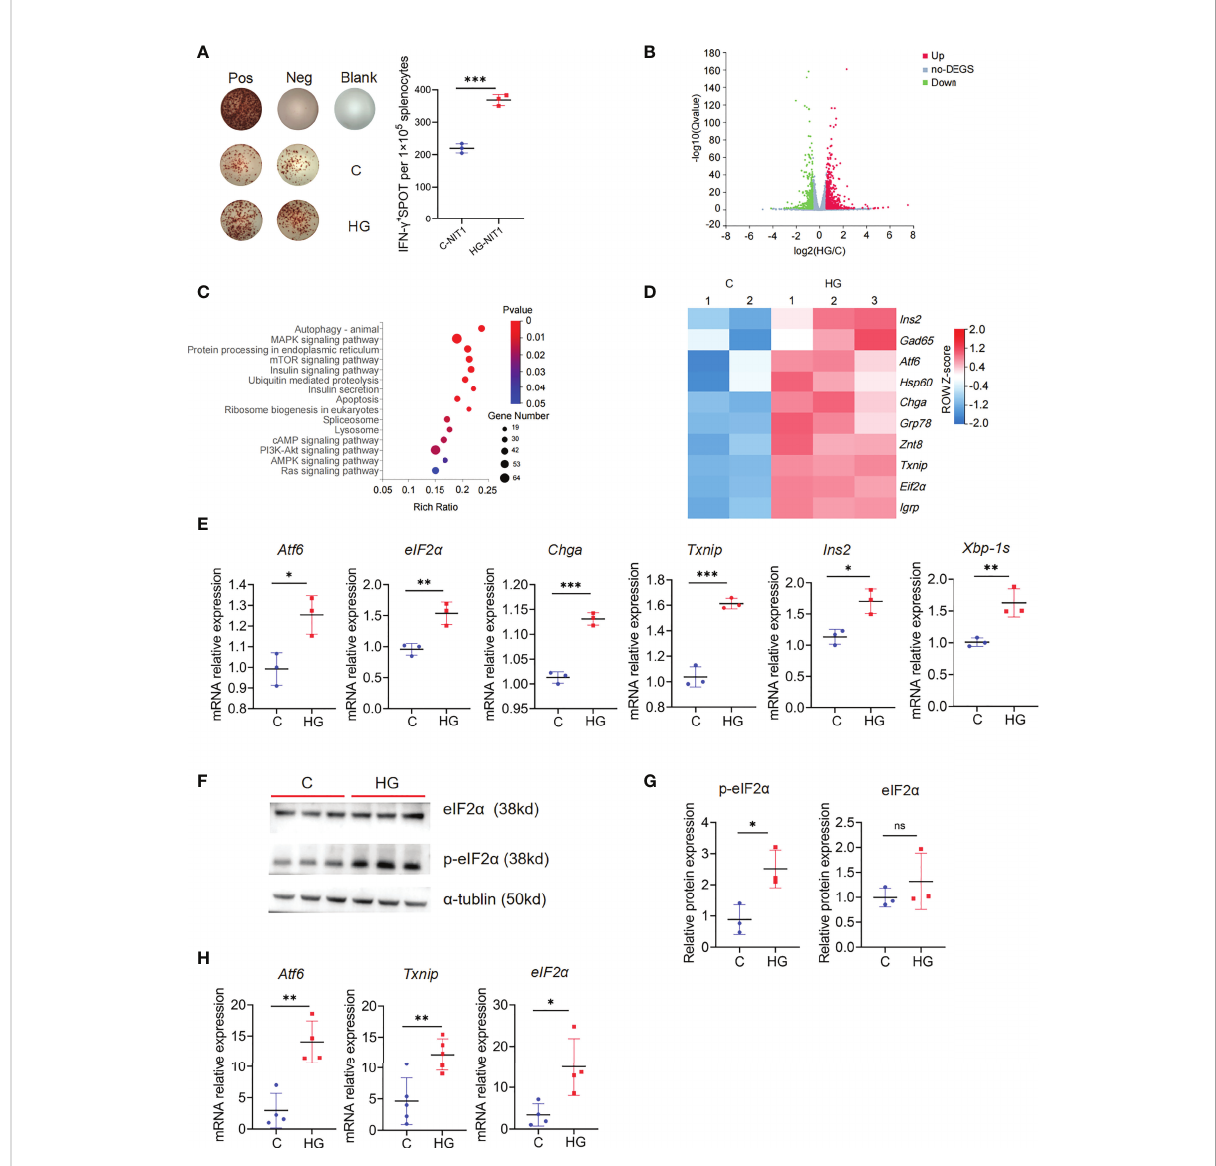
FIGURE 2 High-glucose treatment enhance the immunogenicity of NIT-1 cells and up-regulate the autoantigen and ERS related genes expression (A) Representative plots of IFN- g production by NOD mouse splenocyte alone (Neg), or incubated with untreated (C-NIT1) or high-glucose treated NIT-1 cells (HG-NIT1), or PMA plus ionomycin (Pos). Summary data are presented as the mean IFN- g spots number per 1x10 5 splenocytes ± SD in triplicate for one representative result of at least two independent experiments. (B) The volcano plot of NIT-1 cell transcriptome after high-glucose treatment, 684 genes were up-regulated (red dot), and 425 genes were down-regulated (blue dot) (|FC| ≥ 1.5, fold change, FDR< 0.05). (C) KEGG pathway analysis of 684 up-regulated genes in high-glucose treated NIT-1 cell transcriptome (|FC| ≥ 1.5, FDR<0.05). (D) The T1D autoantigens and ERS-related genes expression in the transcriptome of NIT-1 cell with or without high-glucose treatment, red means up-regulated and blue means down-regulated, each column depicts a biological duplication. (E) The mRNA levels of ERS-related genes Atf6, eIF2 a , Txnip, Chga , Xbp-1s and Ins in NIT-1 cells with or without high-glucose treatment, which were detected by qPCR. (F) The protein level of p-eIF2 a and eIF2 a in untreated NIT-1 cell (C) and high-glucose treated NIT-1 cell (HG) detected by western blot. (G) The ratio of p-eIF2 a /tublin and eIF2 a /tublin were quanti fi ed. (H) The mRNA levels of ERS-related genes Atf6, eIF2 a and Txnip in pancreatic tail tissues of NOD mouse, which were detected by qPCR (n=5). Three independent biological samples were used for quantitative PCR and WB analysis. Summary data are presented as mean ± SEM. *p < 0.05, **p < 0.01, and ***p < 0.001, unpaired two-tailed Student ’ s t